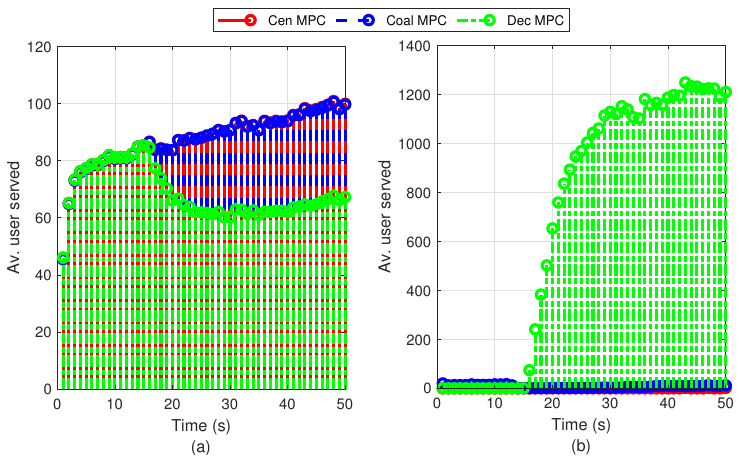
Figure 7. Average users served for the MPC-based methods in the 37-BS network: ( a ) SCBSs, and ( b ) MBS.